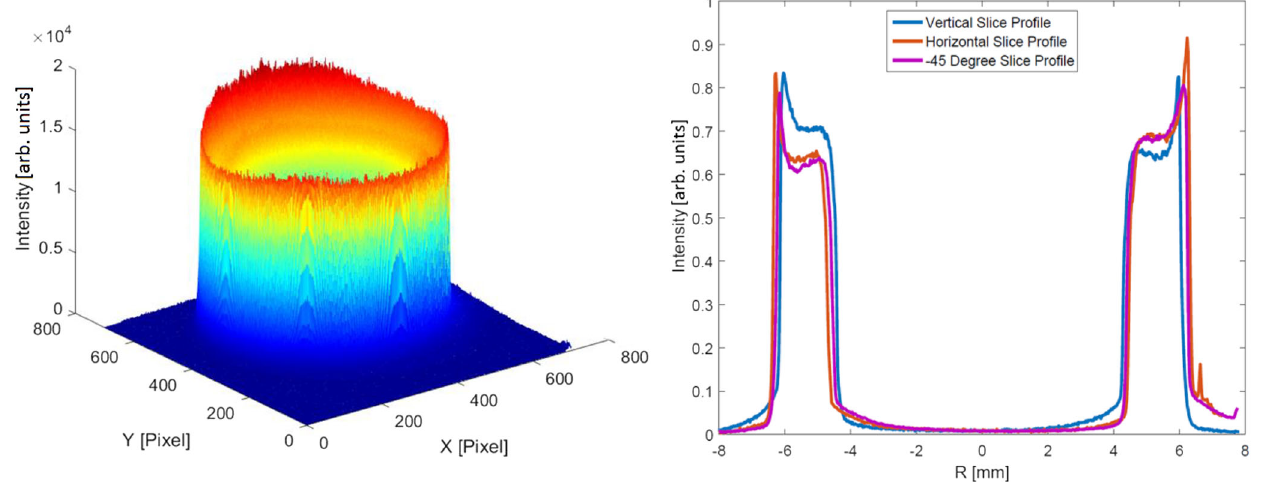
FIG. 6. Measured hollow beam profiles with 0.27 A current and 5 keV